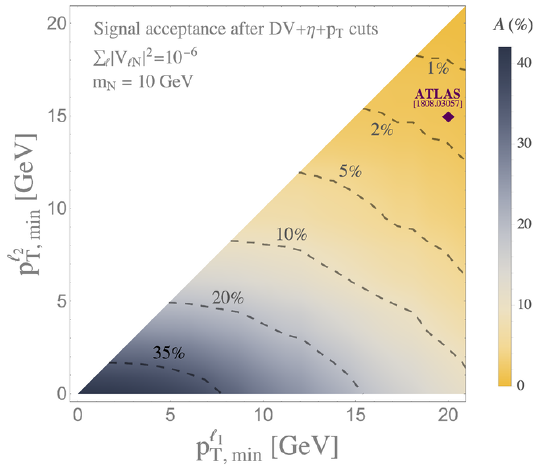
XN X(cid:22) (cid:0) (cid:22) + (cid:23) channel after the (cid:12)rst three cuts ! !